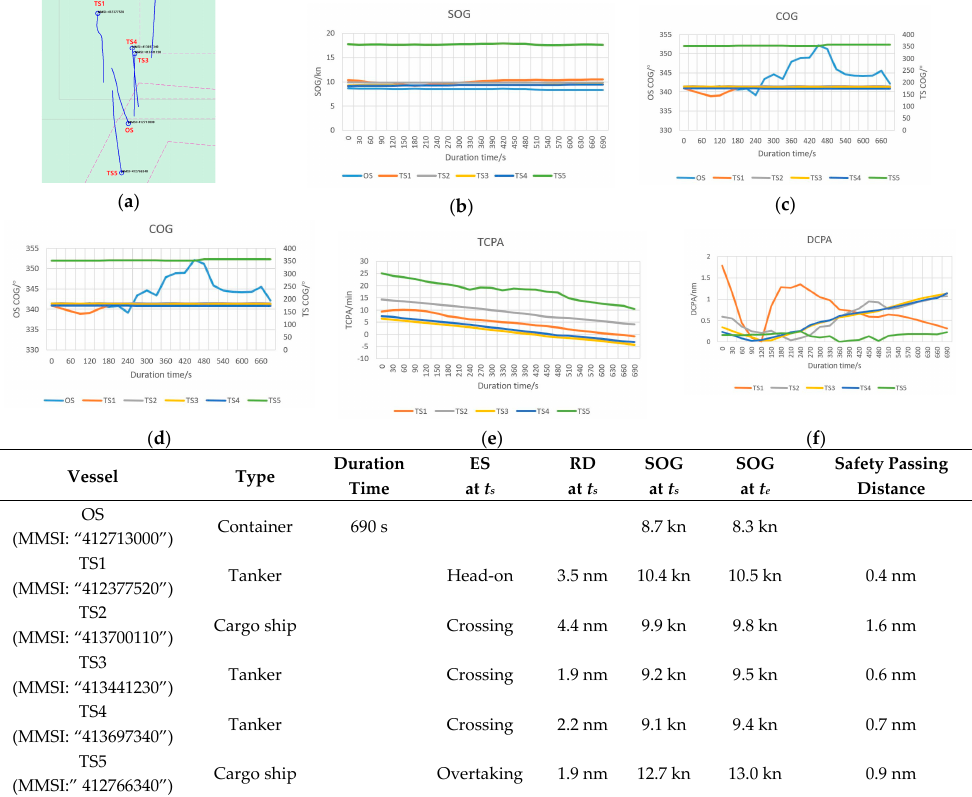
Figure 4. ‘head-on’ situation : ( a ) trajectory; ( b ) SOG; ( c ) COG; ( d ) RD; ( e ) TCPA; ( f ) DCPA; ( g ) scenario parameters aspects. Figure 5 presents a multi-ship encounter situation, where OS (container, MMSI: “412713000”) encounters TS1 (tanker, MMSI: “412377520”) in a head-on situation, OS (give-way ship) and TS2 (cargo vessel, MMSI: “413700110”), TS3 (tanker, MMSI: “413441230”), TS4 (tanker, MMSI: “413697340”), respectively, meet under crossing en- counter rules and OS (stand-on ship) and TS5 (cargo vessel, MMSI: “412766340”, give-